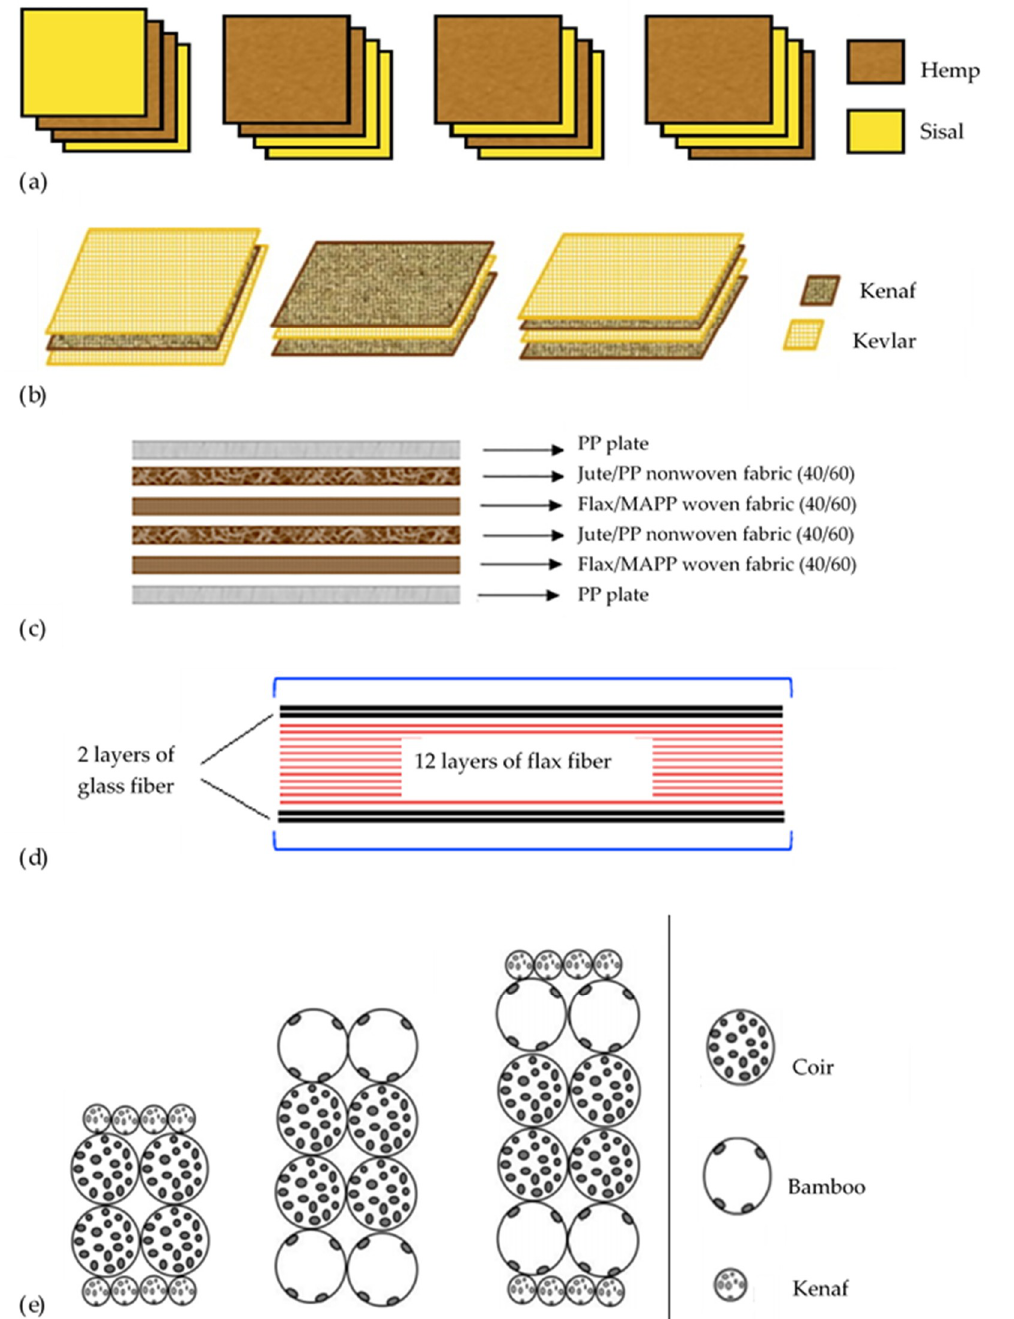
Figure 8. Different stacking configurations of some laminated hybrid biocomposites: ( a ) Hemp/sisal/epoxy. Adapted from [177], ( b ) Kenaf/kevlar/epoxy. Adapted from [178], ( c ) Jute/flax/ ( a ) Hemp / sisal / epoxy. Adapted from [177], ( b ) Kenaf / kevlar / epoxy. Adapted from [178], ( c ) Jute / flax / Polypropylene (PP). Adapted from [179], ( d ) Glass/flax/epoxy. Adapted from [180], ( e ) Polypropylene (PP). Adapted from [179], ( d ) Glass / flax / epoxy. Adapted from [180], ( e ) Coir / kenaf / epoxy, Coir/kenaf/epoxy, bamboo/coir/epoxy and kenaf/bamboo/coir/epoxy. Adapted from [181]. bamboo / coir / epoxy and kenaf / bamboo / coir / epoxy. Adapted from